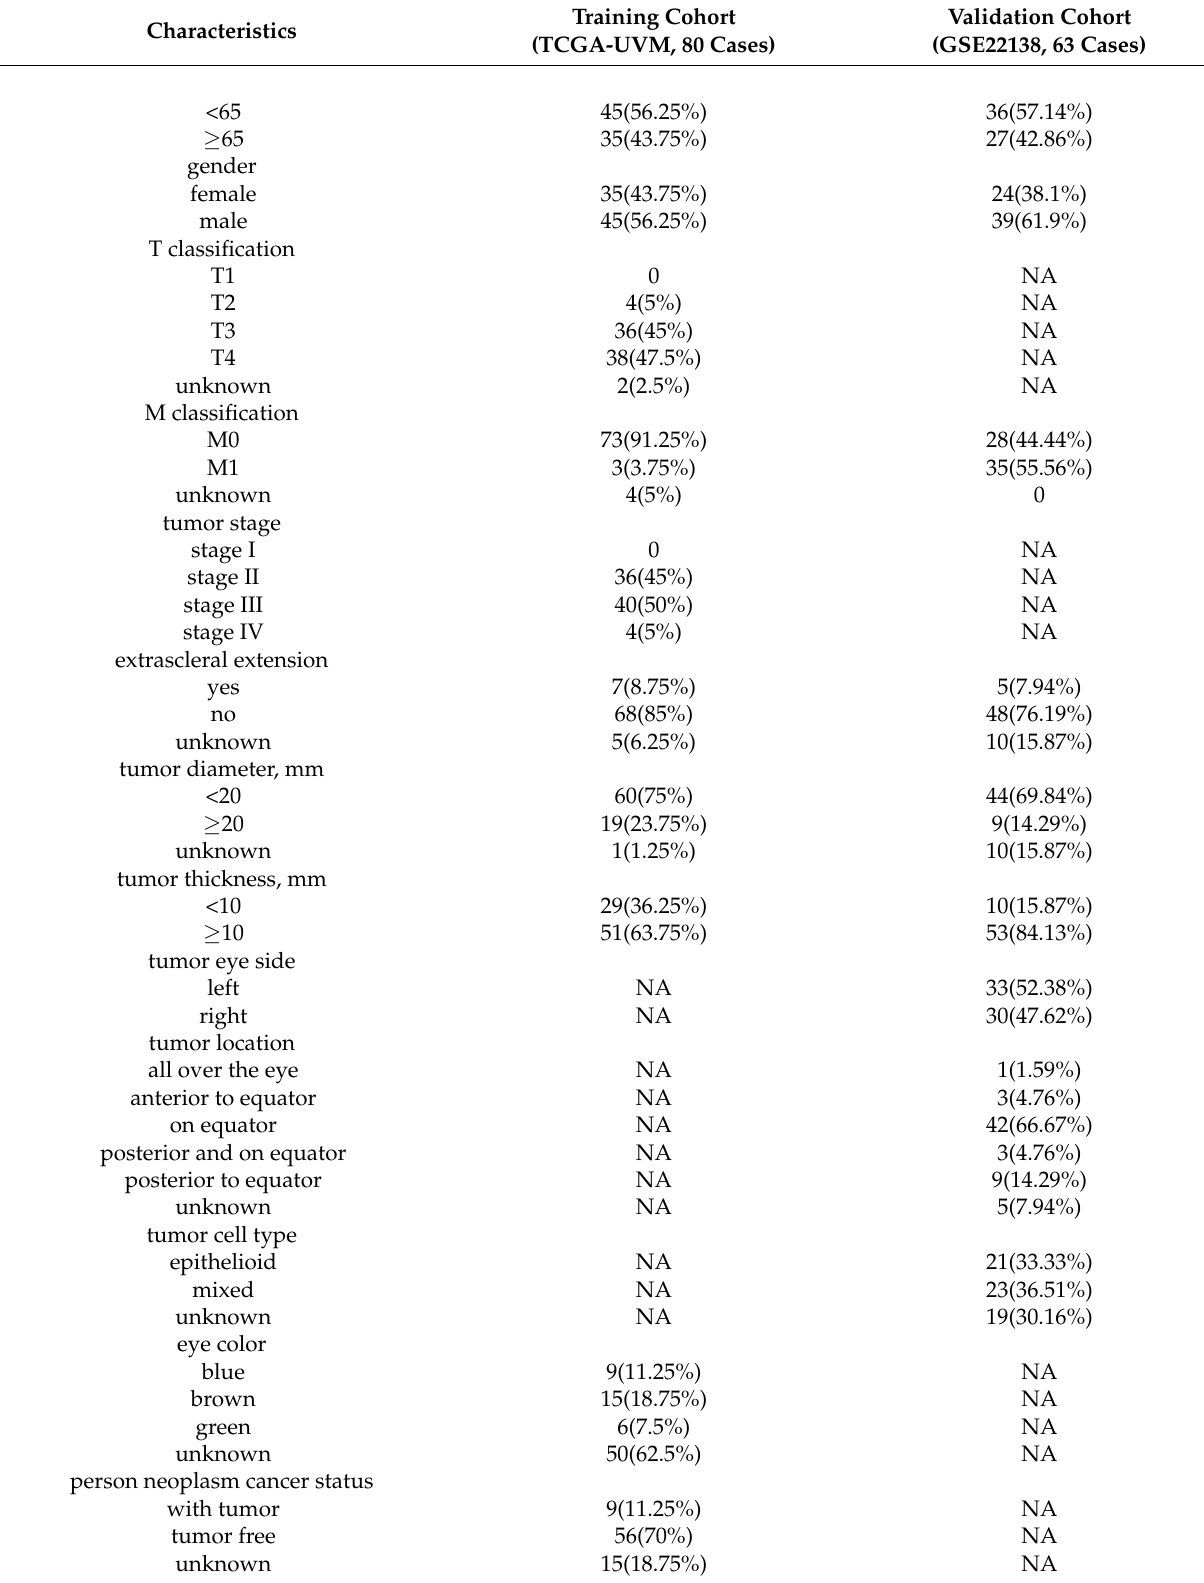
Table 1. Clinical characteristics of patients involved in the